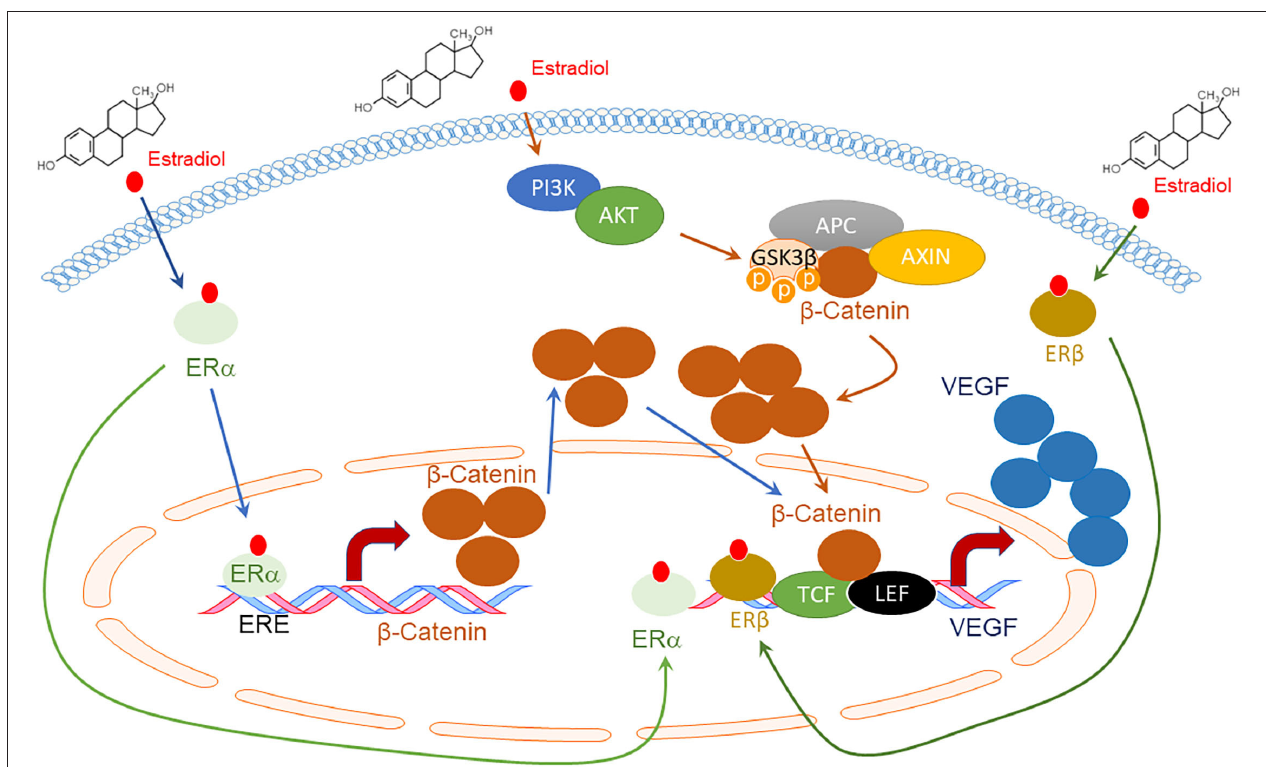
FIGURE 1 | Schematic diagram of VEGF expression by Estradiol (E2) and Estrogen Receptors (ERs) through the Wnt/ β -catenin signaling pathway. E2 promotes the direct binding of ER α to the Estrogen Response Element (ERE) site of the β -catenin promotor, enhancing its expression (45). E2 also activates the Phosphoinositide 3-kinases (PI3Ks)/AKT serine-threonine protein kinase (AKT) axis, which inactivates Glycogen synthase kinase (GSK) 3 β through phosphorylation. The inhibited β -catenin destruction complex, which consists of APC regulator of WNT signaling pathways (APC) and Axis Inhibition Protein ( AXIN), decreases β -catenin degradation. Accumulated β -Catenin enters the nucleus to bind to transcription factor 3/lymphoid enhancing binding factor 1 (TCF3/LEF1), enhancing VEGF expression ( 45). ER α and ER β also directly bind to the VEGF promoter region and increase VEGF expression upon E2 activation